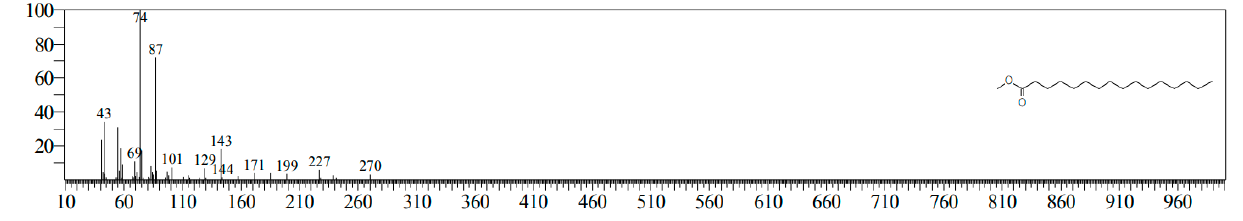
Figure 10. Comp Name: Hexadecanoic acid, methyl ester, Run Time: 15.402, Mol Weight: 270.